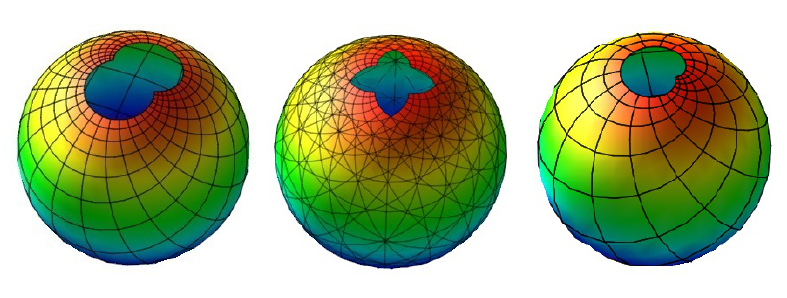
Figure 3. The Gauss maps ( Left ) e 2 ( u , v ) , ( Middle ) e 3 ( u , v ) , ( Right ) e 4 ( u , v ) . Richmond’s minimal surface S 2 ( u , v ) in ( 6 ) has class 12. See [23,24] for details. Using ( λ 3 − 3 ) (6), (7), (10), and (11), with P 2 ( u , v ) = − 4 u , we get the surface (cid:98) S 2 ( u , v ) in the following 3 ( λ 2 + 1 ) inhomogeneous tangential